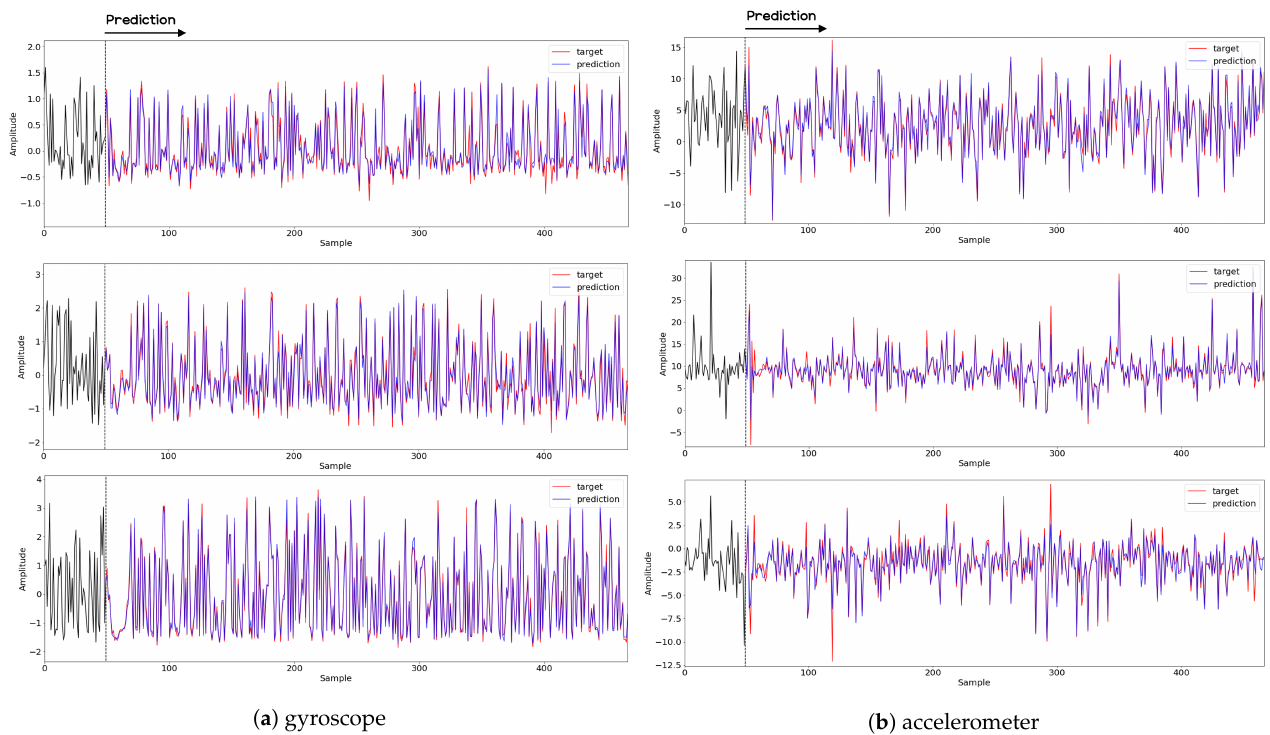
Figure 22. Samples of recovery results from the decoder model for walking motion. The top, middle, and bottom rows represent the x-, y-, and z-axis, respectively. The blue and red lines indicate the predicted signal from the FNO model and target signal, respectively, and the black line represents the signal corresponding to the input entered into the FNO model.